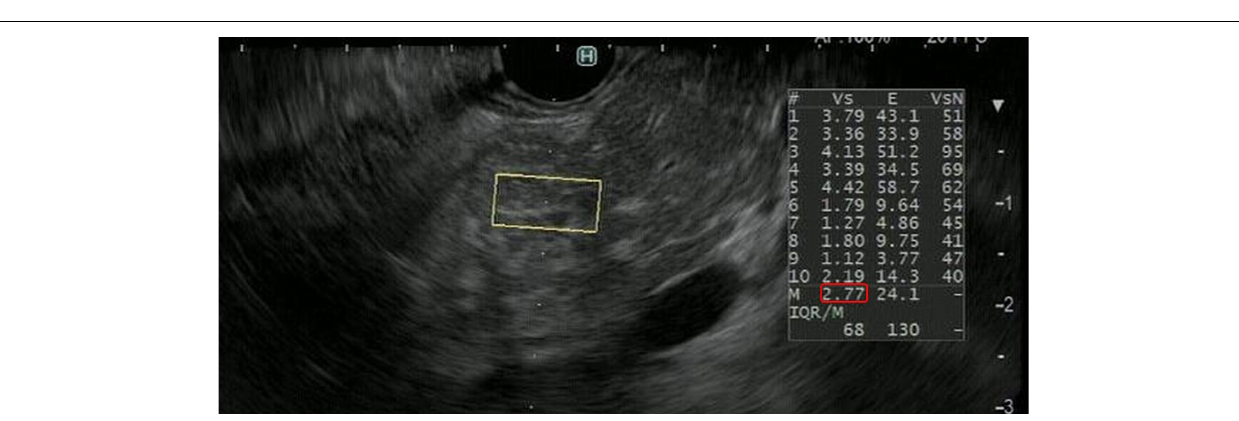
Frontiers in Physiology |